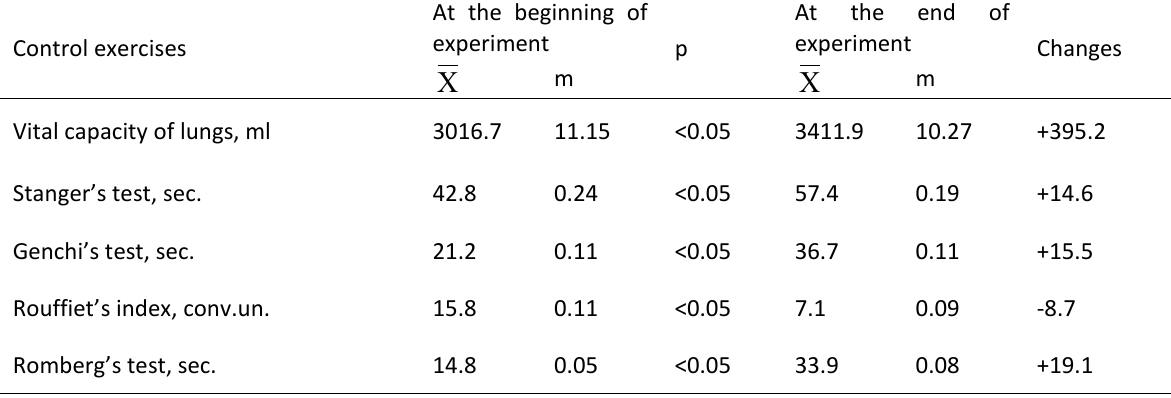
Table 2. Changes in indicators of health and functional state of group 1 girl students at the end of comparative